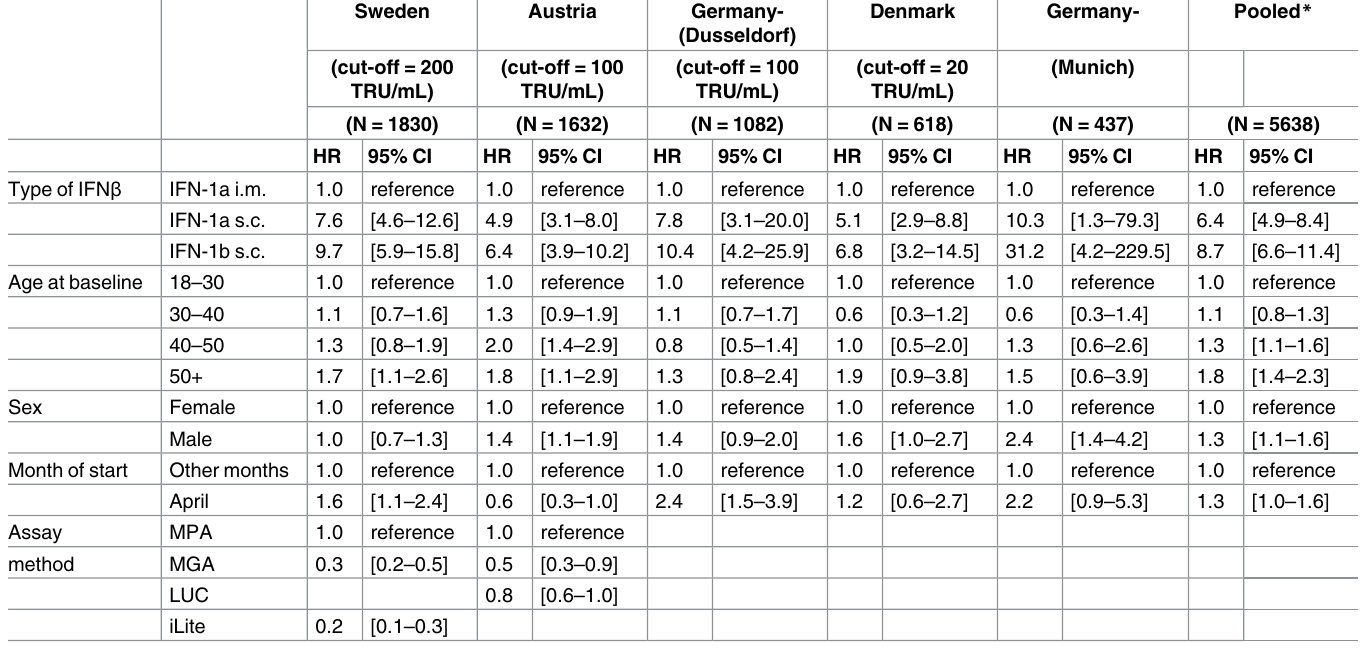
Table 3. Adjusted hazard ratios for risk factors of anti-IFN β ADA